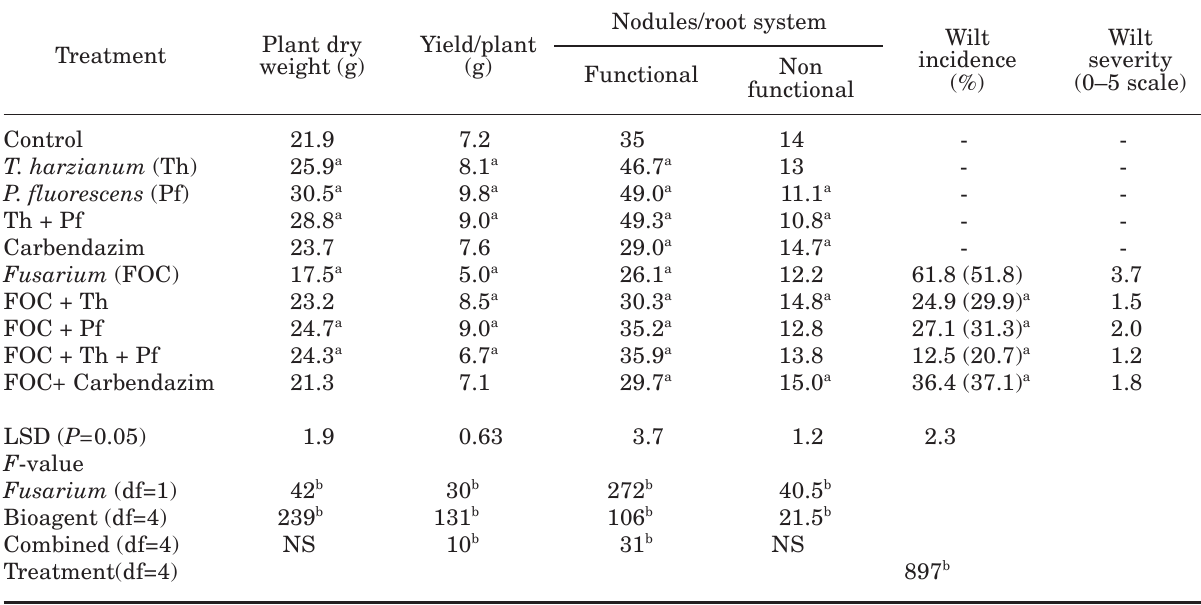
Table 1. Effect of seed treatment with biofungicides on dry matter, yield, nodulation, wilt incidence and severity of chickpea plants inoculated with Fusarium oxysporum f. sp. ciceri or not